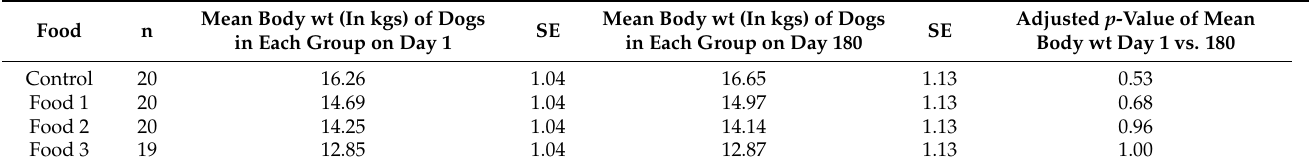
Table 3. Mean Body weights (in kgs) of each group, at the beginning and at end of the test phase. (Control, Food 1, Food 2 and Food 3 have 0 ppm, 75 ppm, 150 ppm and 300 ppm of a-LA respectively.) Mean Body wt (In kgs) of Dogs Mean Body wt (In kgs) of Dogs Adjusted p -Value of Mean Food n SE SE in Each Group on Day 1 in Each Group on Day 180 Body wt Day 1 vs. 180 Control